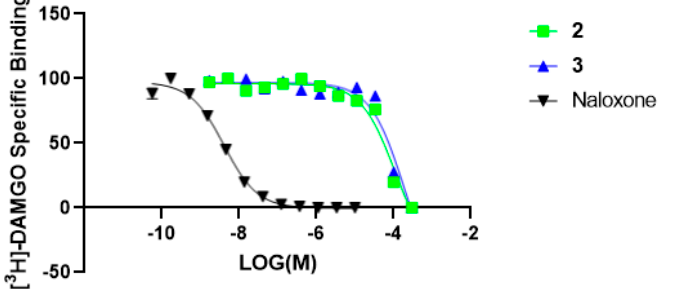
Figure 4. The radioligand displacement curves were obtained for compounds ( 2 and 3 ) for the µ opioid receptor. Naloxone hydrochloride was used as a positive control.